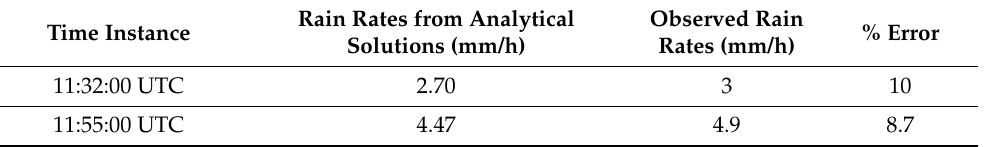
Table 2. Rain Gauge observations and Analytical Predictions of Rain